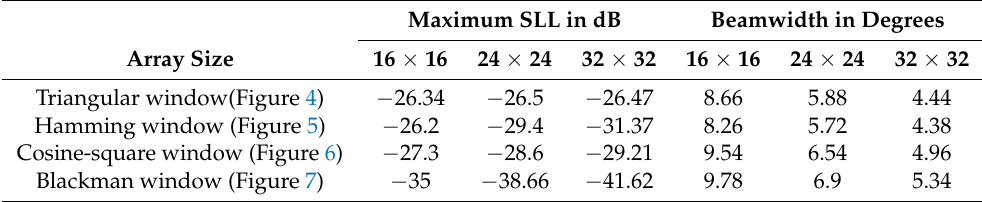
Table 1. Cross-linear 2D windows performance at different array sizes.